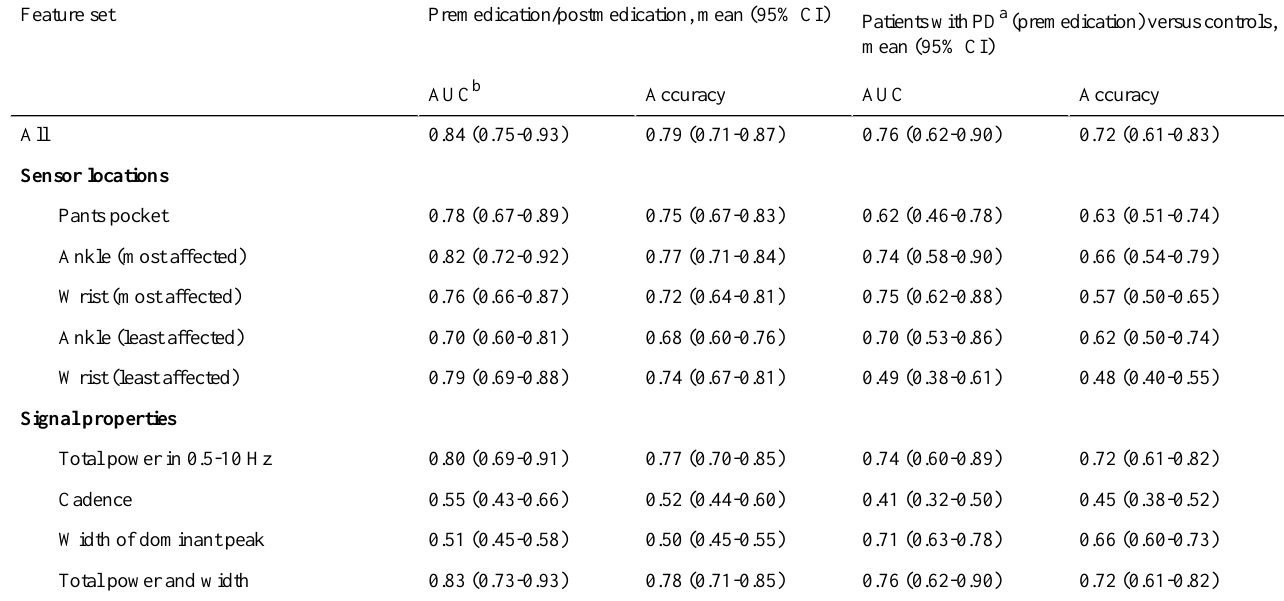
Table 3. Performance of the logistic classifiers (mean, SE 1.96 over the cross-validation folds). Accuracies are based on the optimal classifier for each fold with equal misclassification costs and equal class prior (also referred to as balanced